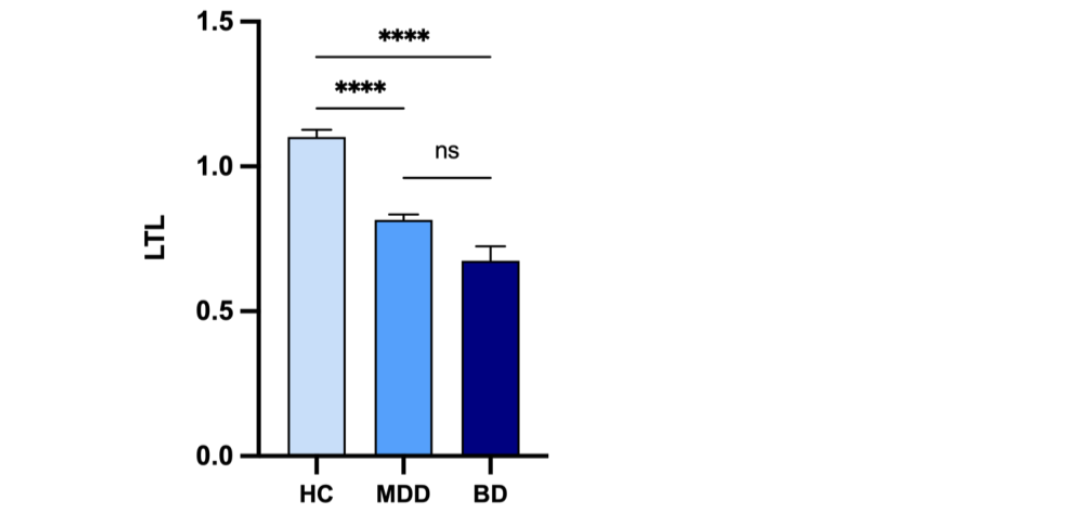
Table 3. Comparison of baseline LTL in relation to ECT response. Unadjusted Analyses Analyses Adjusted for